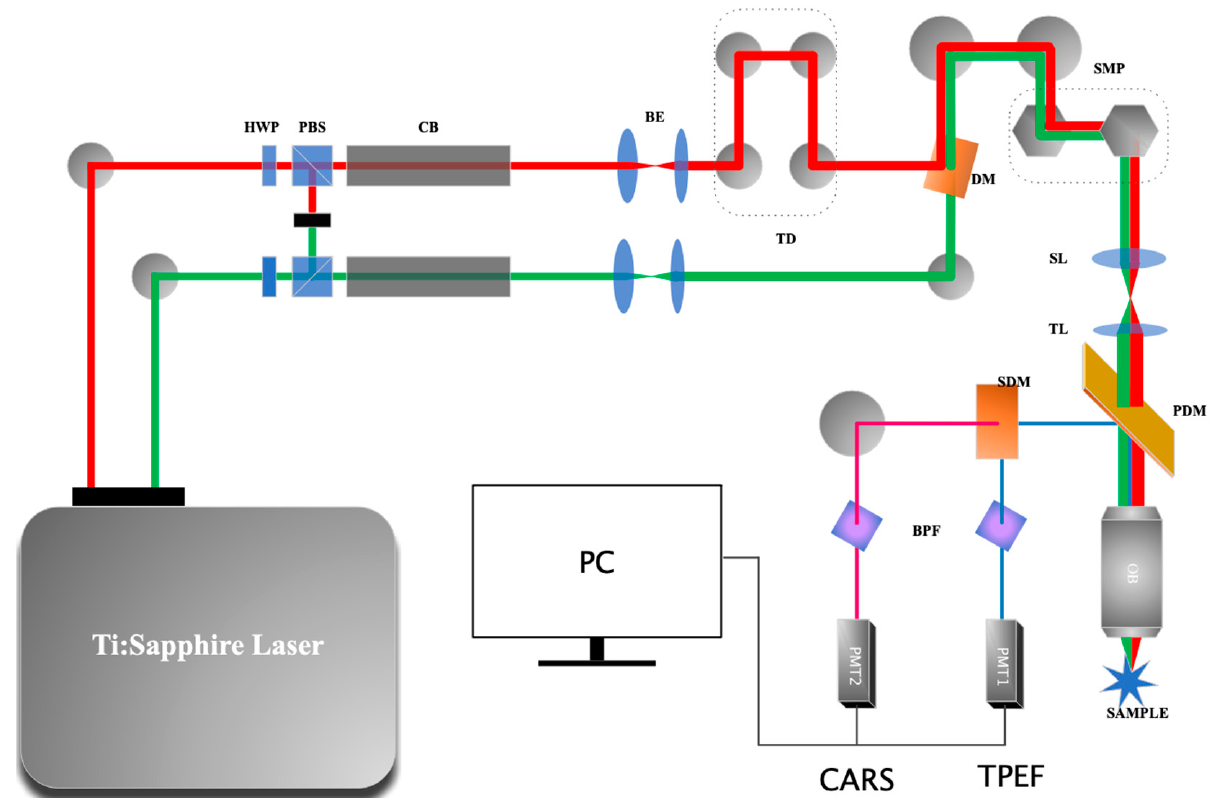
Figure 1. Schematic diagram of the CARS system. Ti: Sapphire Laser, titanium-doped sapphire solid-state laser with two outputs; HWP, half-wave plate; PBS, polarization beam splitter; CB, chirped block; BE, beam expander; TD, time delay; DM, dichroic mirror; SMP, scanning mirror pairs; SL, scan lens; TL, tube lens; PDM, primary dichroic mirror; OB, objective lens; SDM, secondary dichroic mirror; BPF, band-pass filter; PMT, photomultiplier.